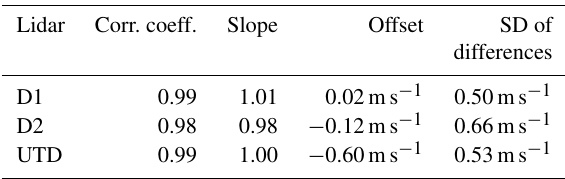
Table 4. Comparison of the instantaneous lidar LOS measurement to sonic-derived LOS measurement at all sonic